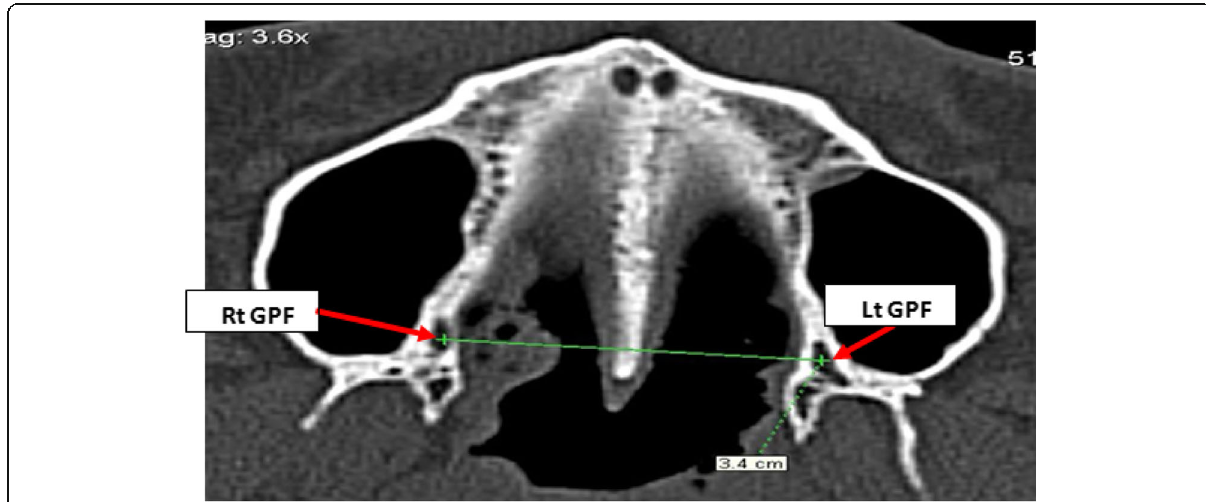
Fig. 14 A CT scan at the region of hard palate illustrating the distance from the center of greater palatine foramen to the center of opposite greater palatine foramen